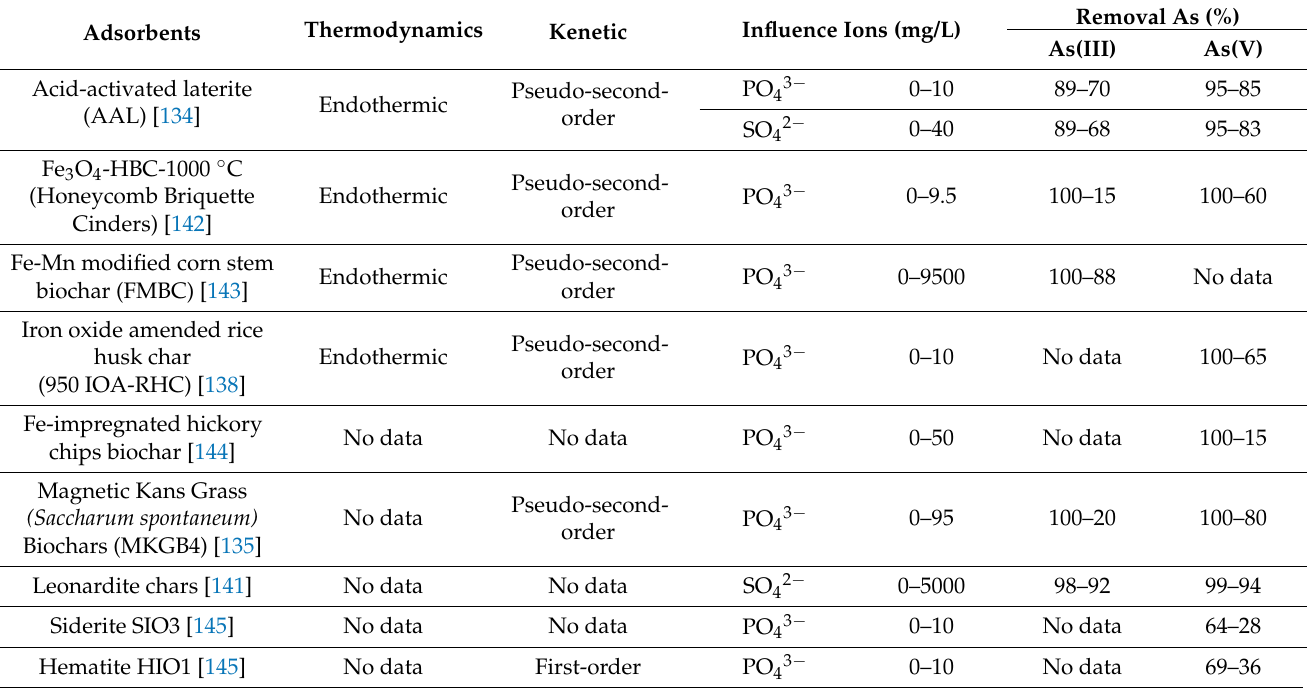
Table 4. Other ions influence on some natural